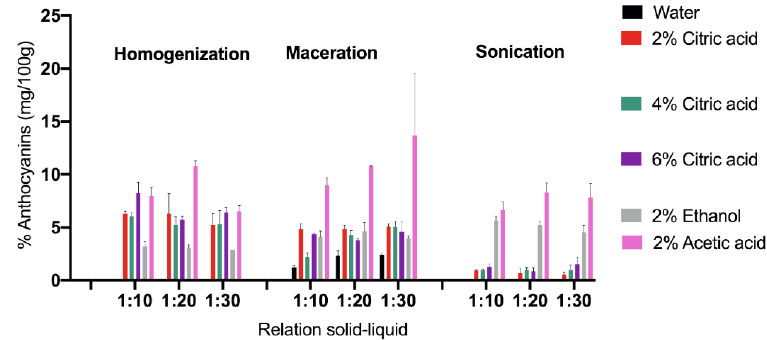
Fig. 2: Anthocyanin yields in fresh dahlia petal extracts Tab. 2: Anthocyanin yields in dried dahlia petal